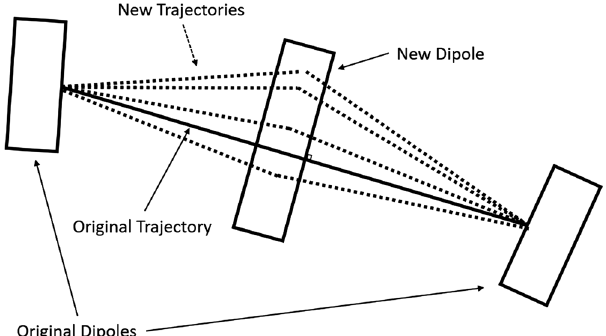
FIG. 13. Schematic of new dipole with the original trajectory (solid) and different new trajectories (dashed) for different R 56 values. For very low values of R 56 the original dipoles become reverse bends.